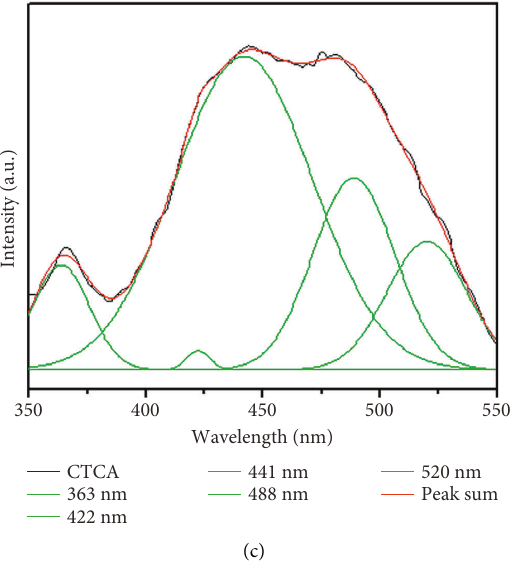
Figure 4: FTIR (a), UV-Vis absorbance (b), and photoluminescence spectra (c) analysis of nanocomposites.